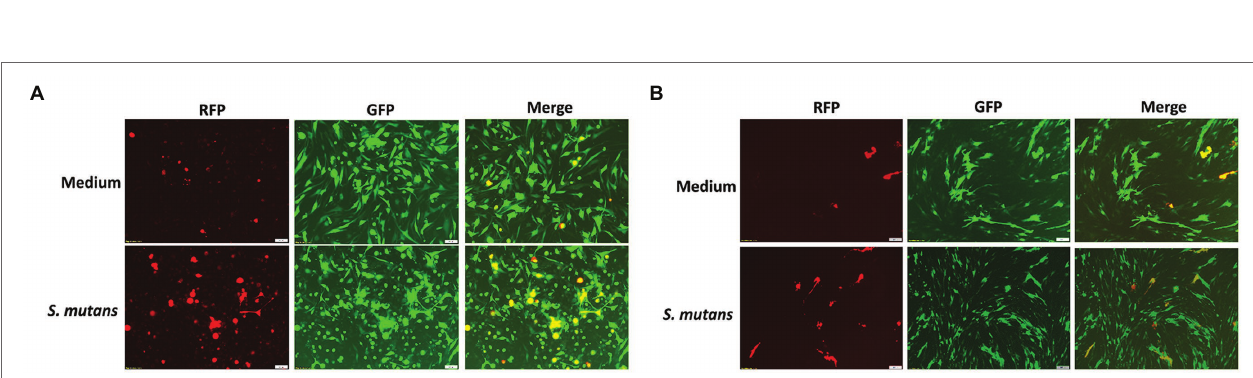
FIGURE 6 | Induction of KSHV lytic reactivation by Streptococcus species. (A,B) Oral fibroblasts PDLF and HGF were infected with purified rKSHV.219 virus and treated with filtered conditioned medium of Streptococcus species as described above, and then images were captured by using fluorescence